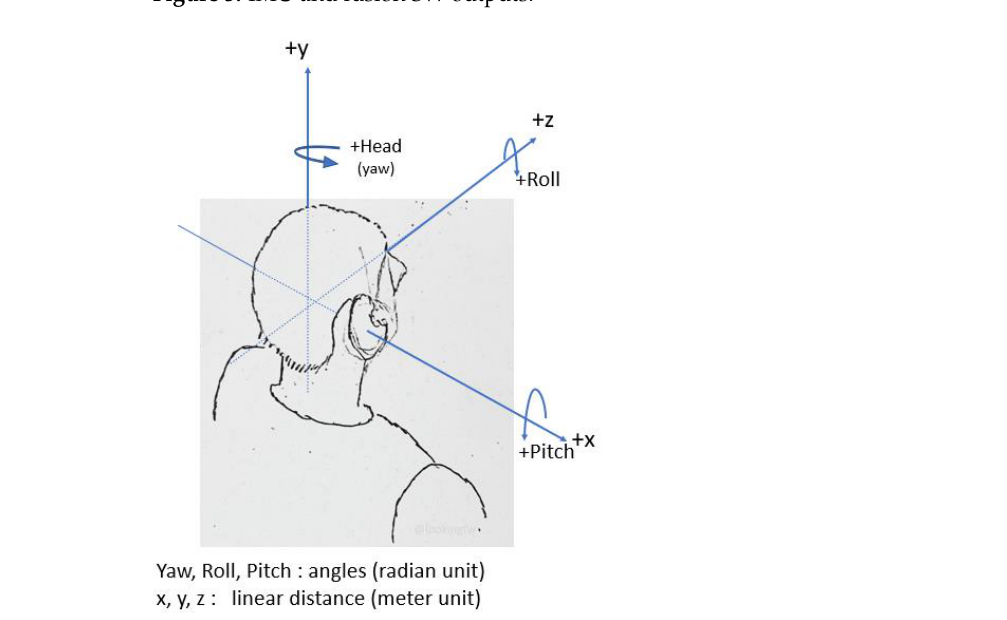
Figure 3. IMU and fusion SW outputs.